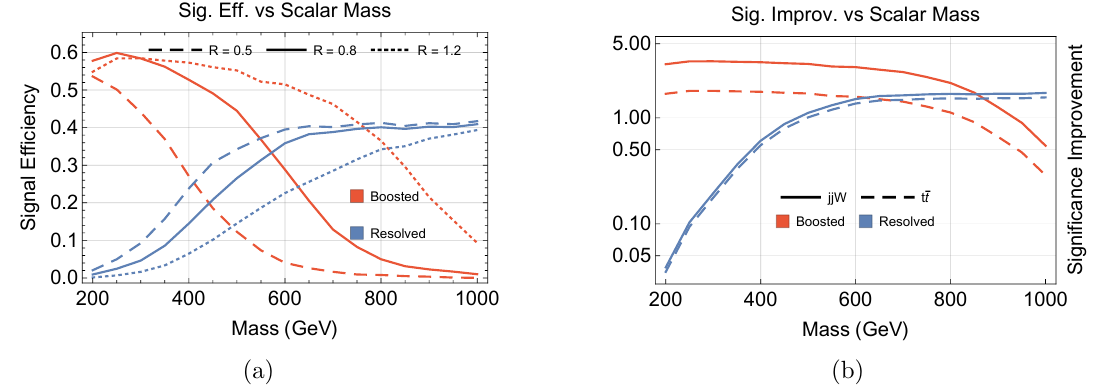
Figure 8. A comparison of the performance of the boosted tagger vs resolved tagger. Left: signal e(cid:14)ciency as a function of scalar mass, for the boosted tagger, as compared to the resolved tagger. Three values for jet radius are considered, as indicated. Right: signi(cid:12)cance Improvement (for the two dominant backgrounds jjW and t (cid:22) t ) as a function of scalar mass, for the boosted tagger, as compared to the resolved tagger. The radius for the boosted (resolved) tagger is taken to be 1.2 (0.8). In both cases, the transition happens around 600